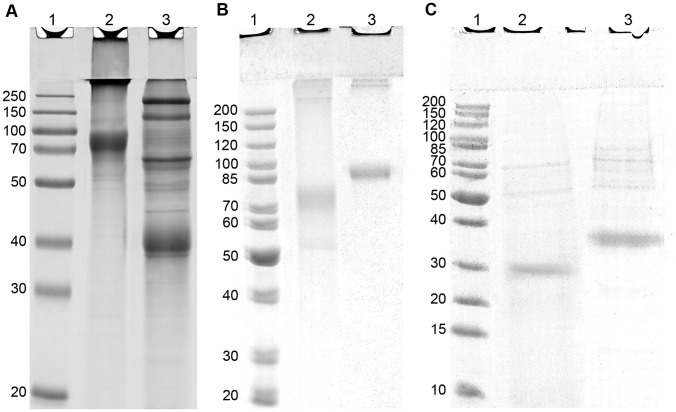
Images of Coomassie blue stained SDS-PAGE gels analysing m-rCLU secreted into FCS-supplemented versus serum-free media.(A) m-rCLU purified from culture medium containing 10% FCS, Lane 1: Molecular weight markers with size indicated in kDa; Lane 2: non-reducing; Lane 3: reducing conditions. (B) Non-reducing and (C) reducing SDS-PAGE analyses of m-rCLU purified from serum-free media and wtCLU. In (B) and (C), Lane 1: Molecular weight markers with size indicated in kDa; Lane 2: Purified m-rCLU; Lane 3: Purified wtCLU.